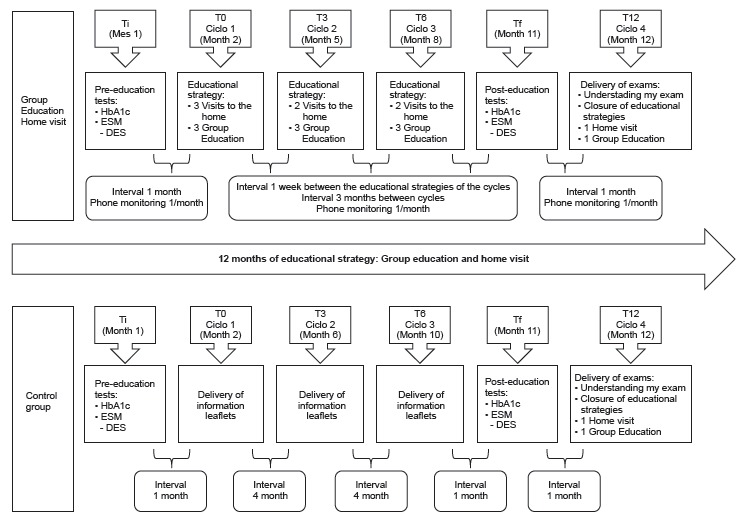
Cycle development stages.